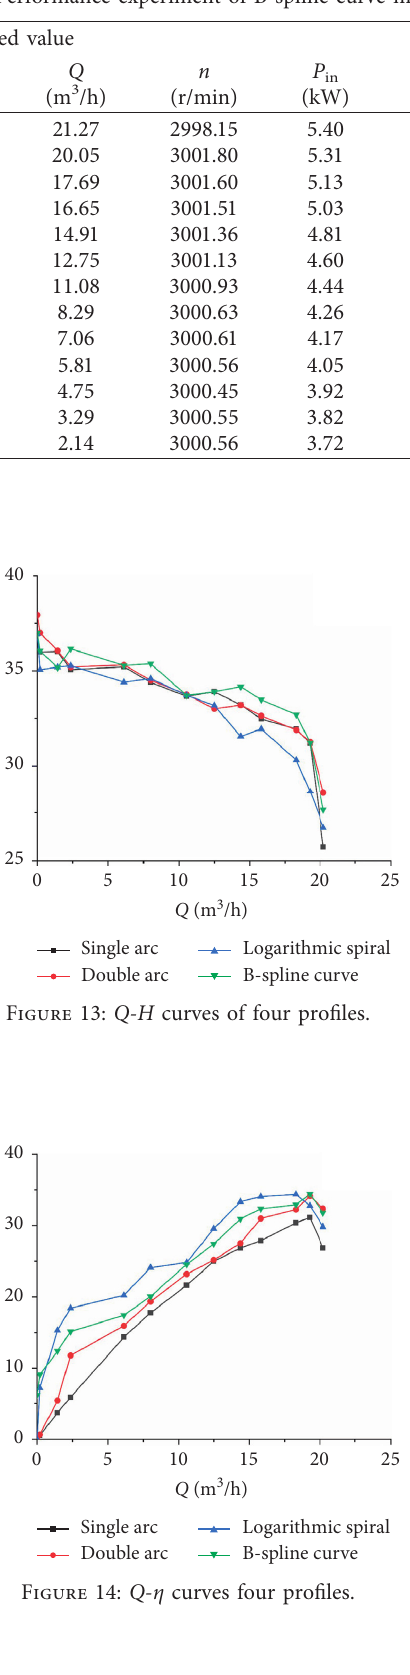
Table 7: Performance experiment of B-spline curve method.